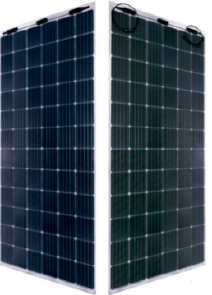
Figure 4. Solar module HVL-360/HJT.